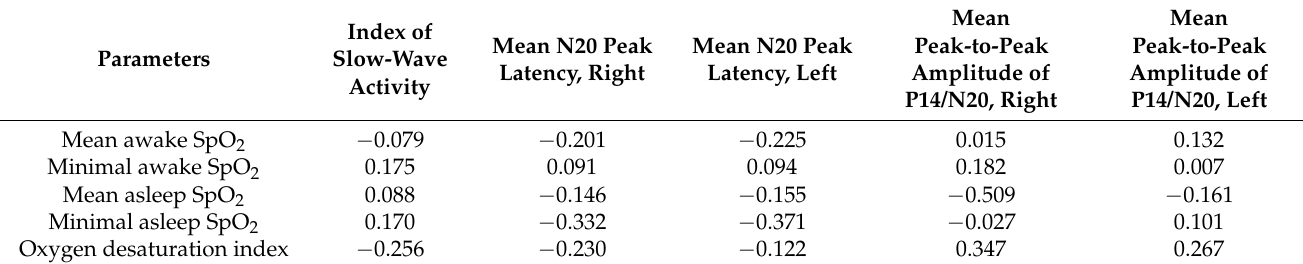
Table 4. Parameters of neurophysiological examination and pulse oximetry.